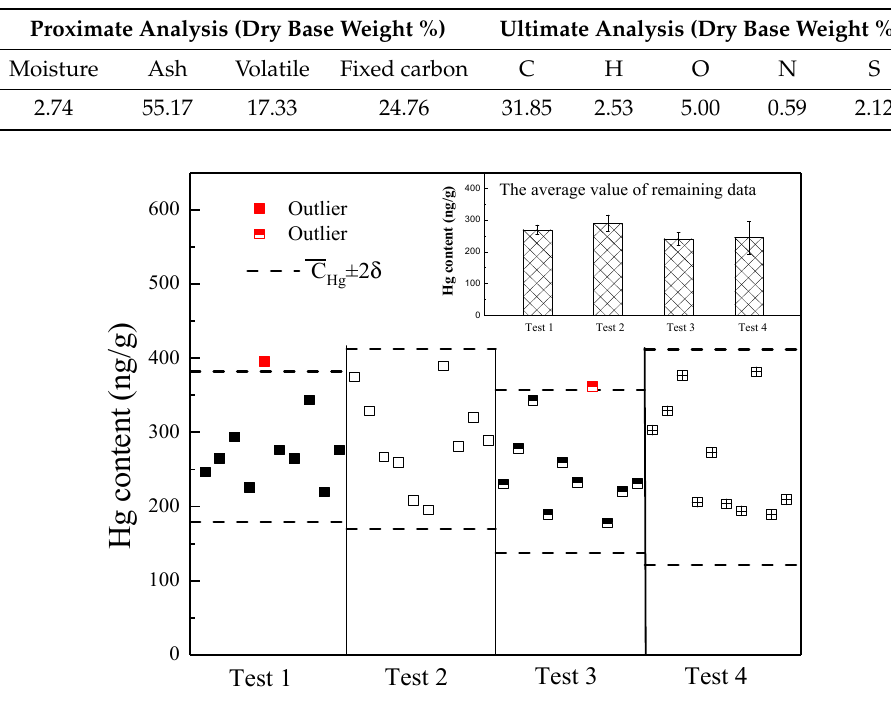
Table 1. Proximate analysis and ultimate analysis of feed fuel samples.